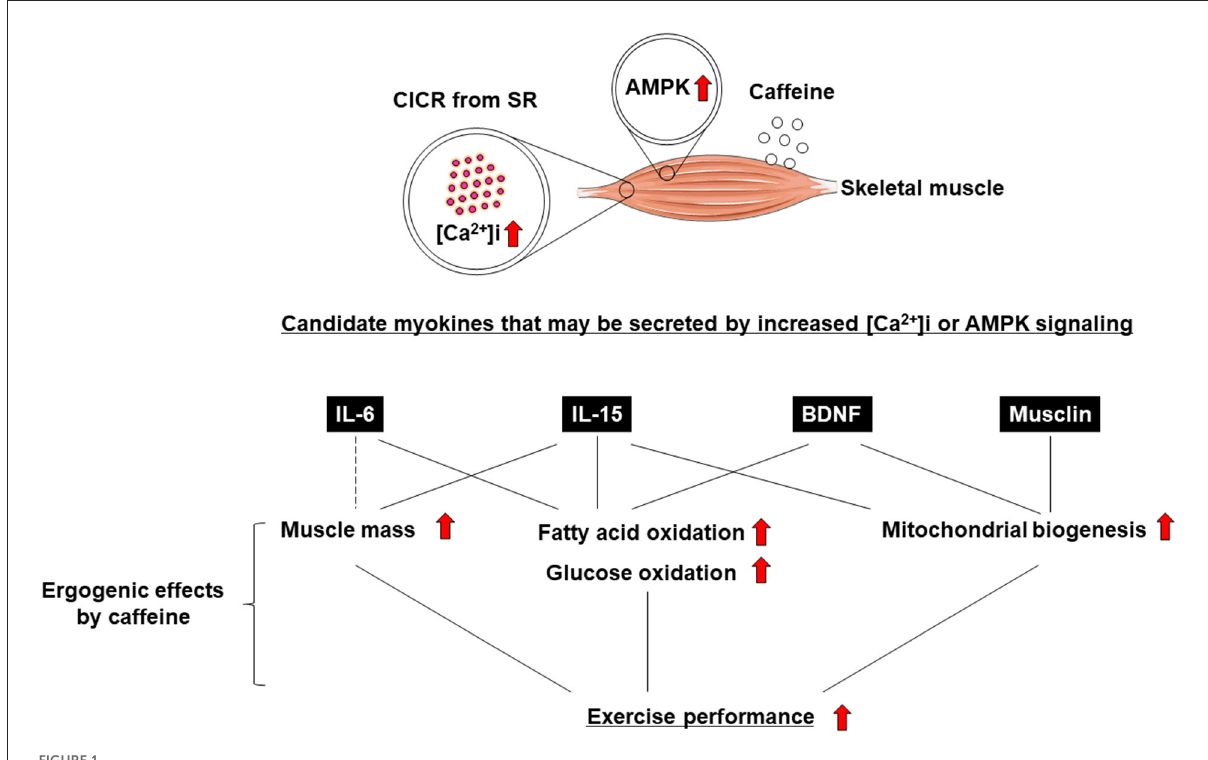
FIGURE1 Ergogenic effects of caffeine are mediated by